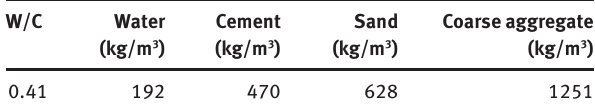
Table 2: Concrete mix design.